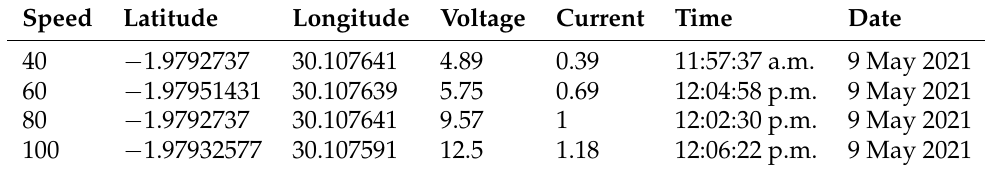
Table 4. Scenario